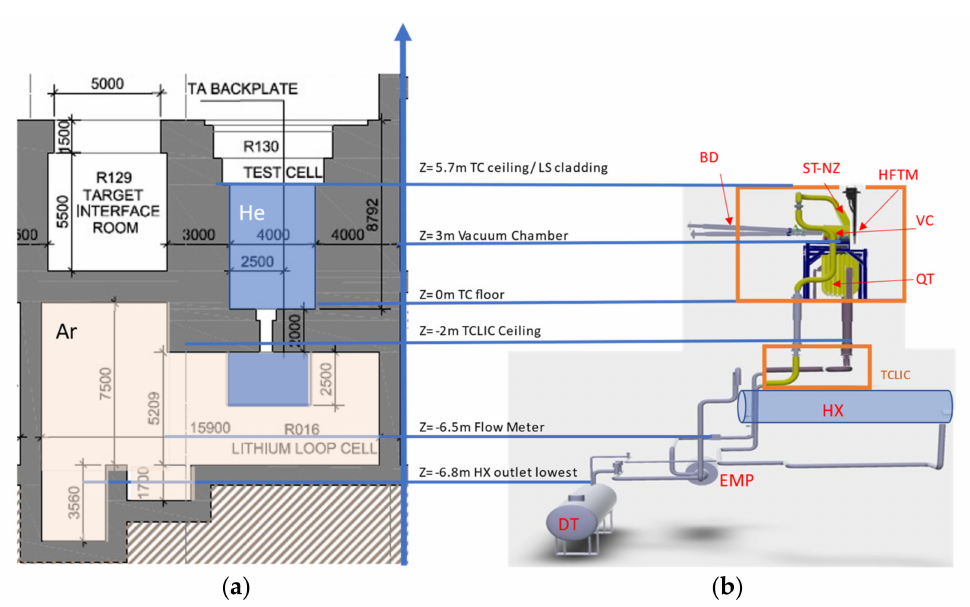
Figure 2. ( a ) Building layout and rooms in scope (light blue). ( b ) Related Melcor model elevations for considered